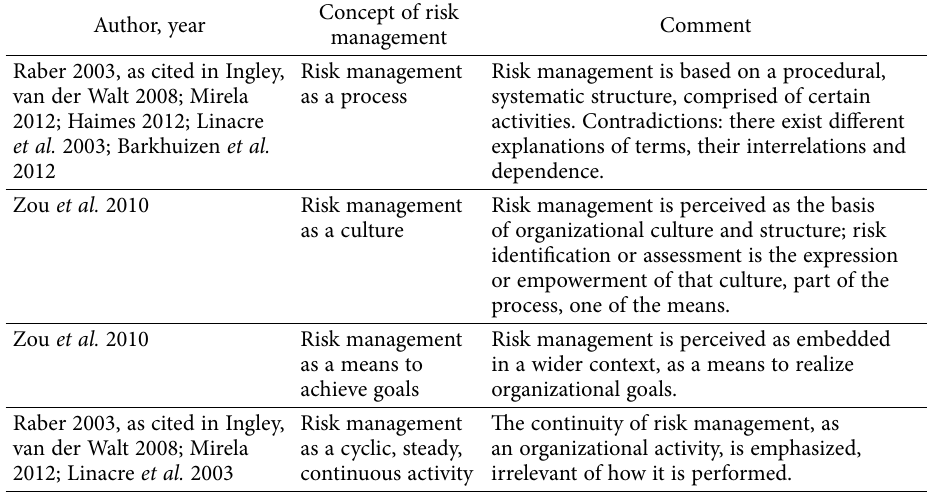
Table 2. Commonalities and contradictions in the definitions of risk management